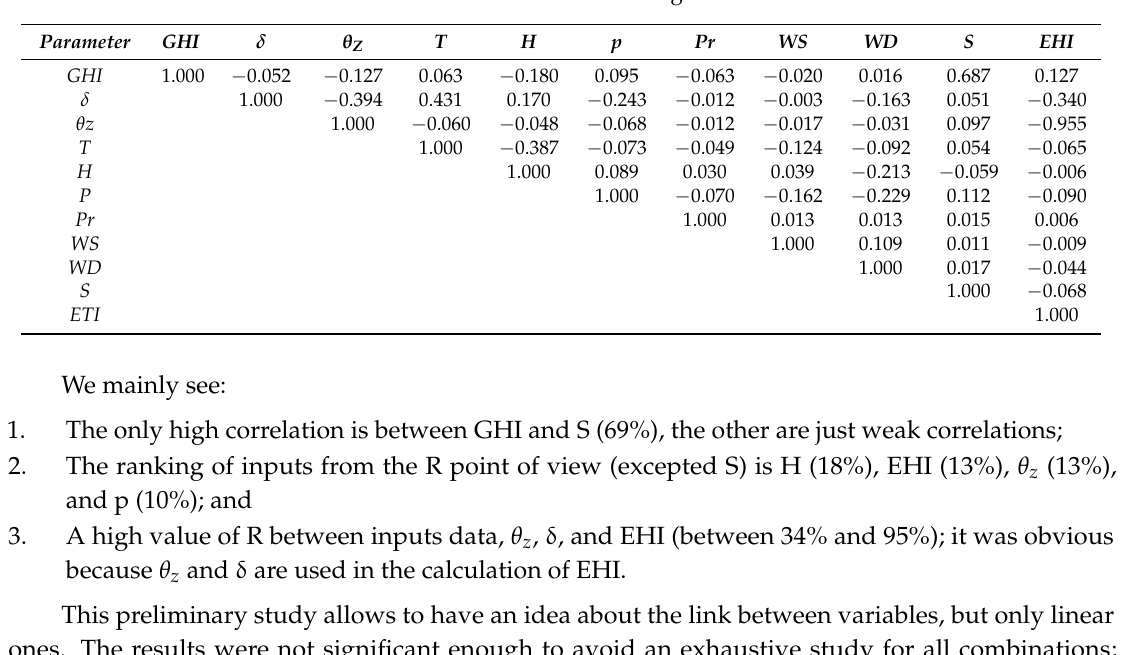
Table 2. Pearson correlation coefficients between meteorological variables for the Bouzareah site.